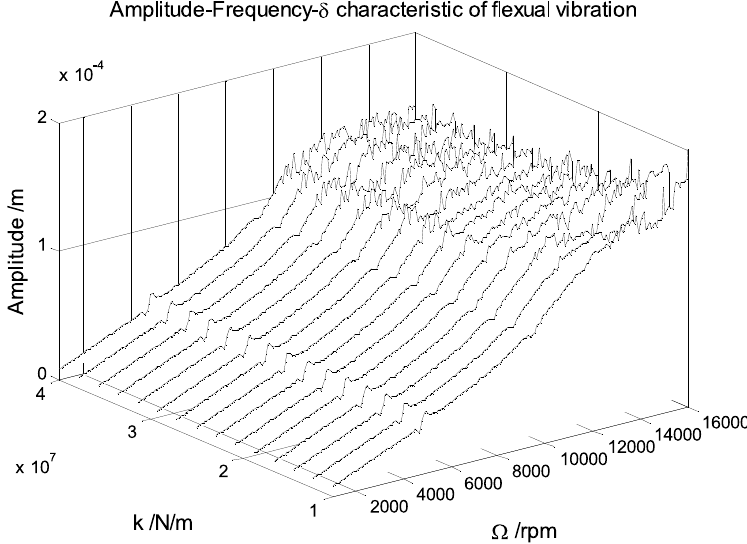
Fig. 6. Relationship of the amplitude of the flexural vibration with, rotational speed and